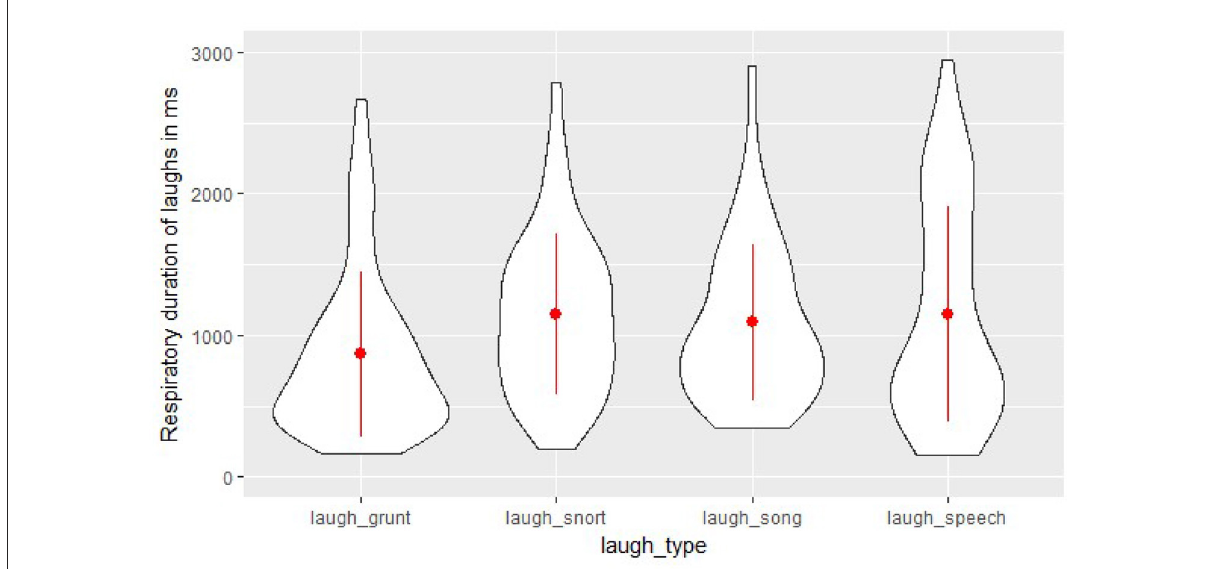
FIGURE6 Violin plots of respiratory durations (in ms) of the four laughter types under investigation. Red dots correspond to the means and red vertical lines to the standard deviations.